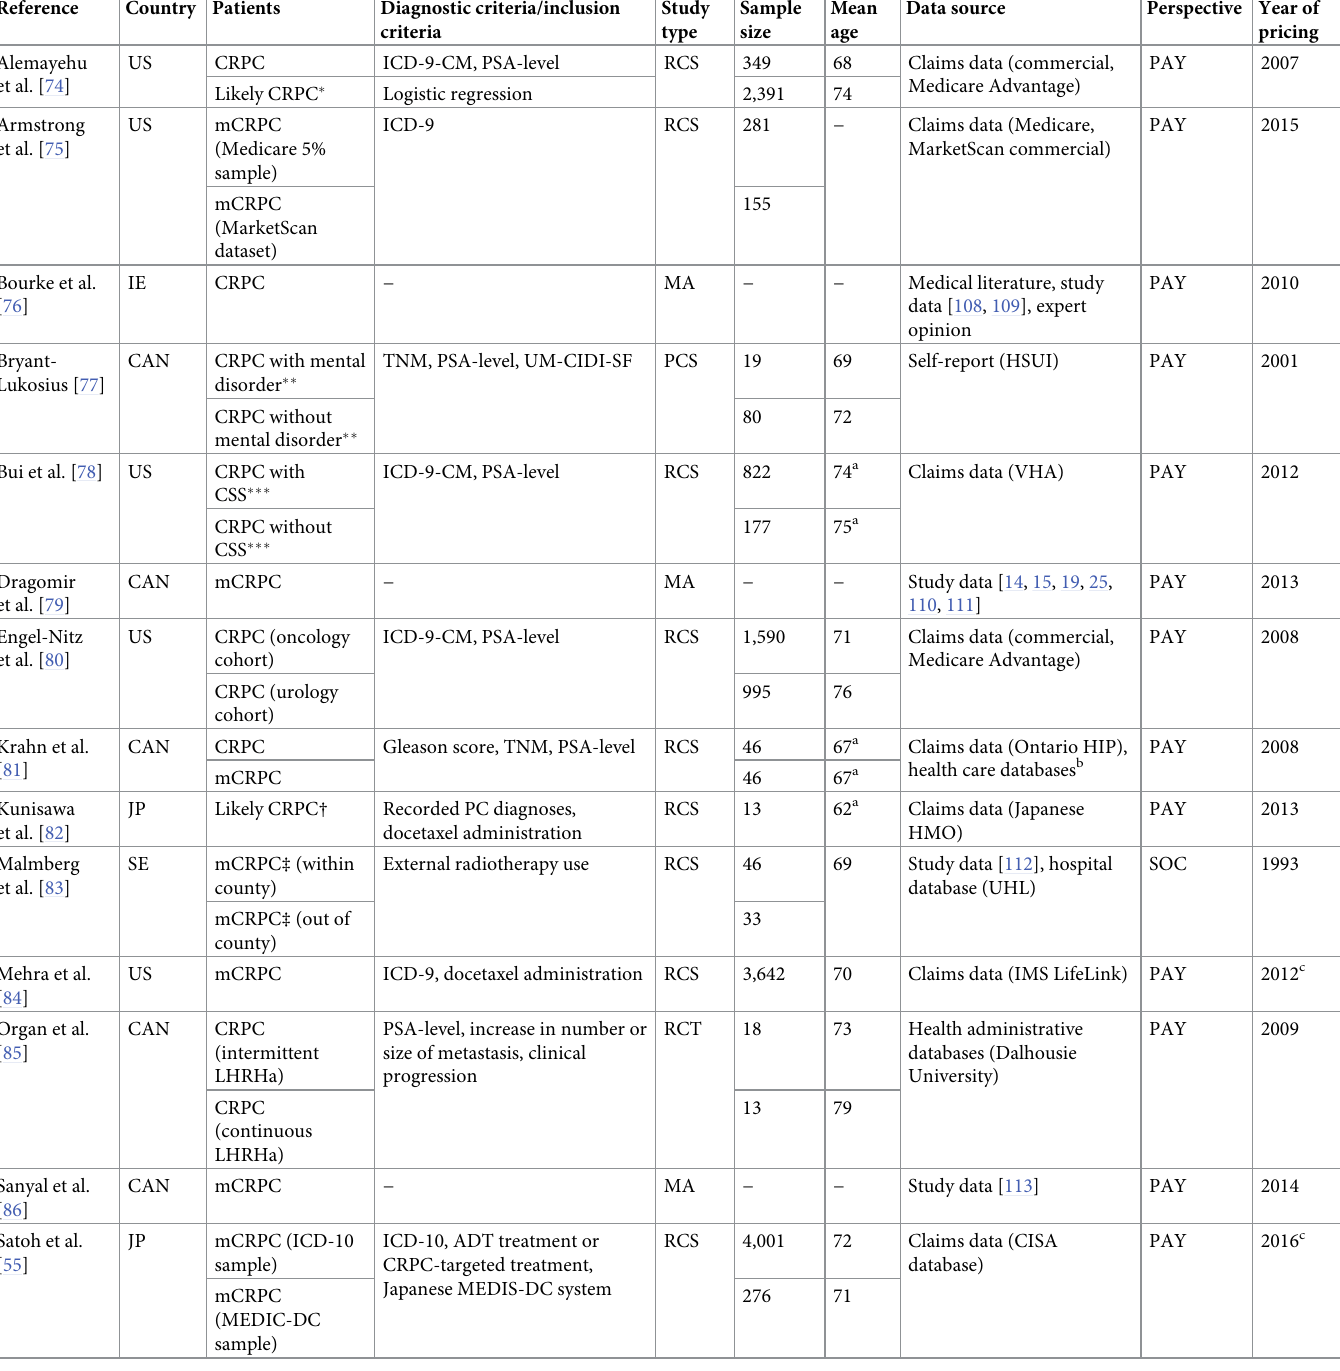
Table 2. General characteristics of included cost-of-illness